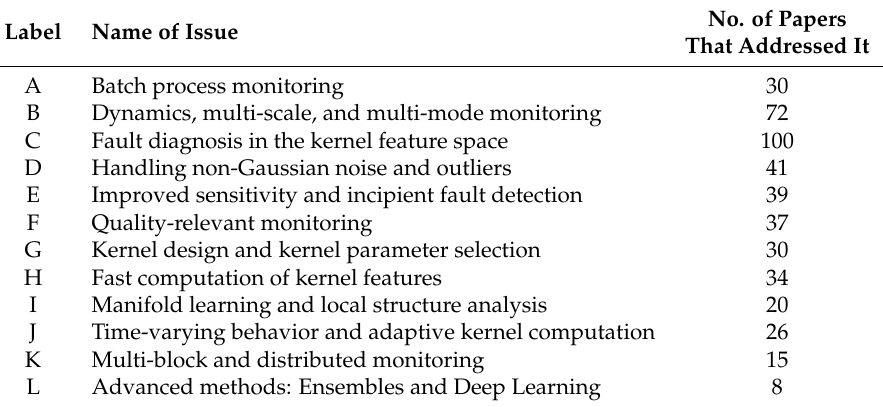
Table 2. Issues surrounding the use of kernel methods for process monitoring.